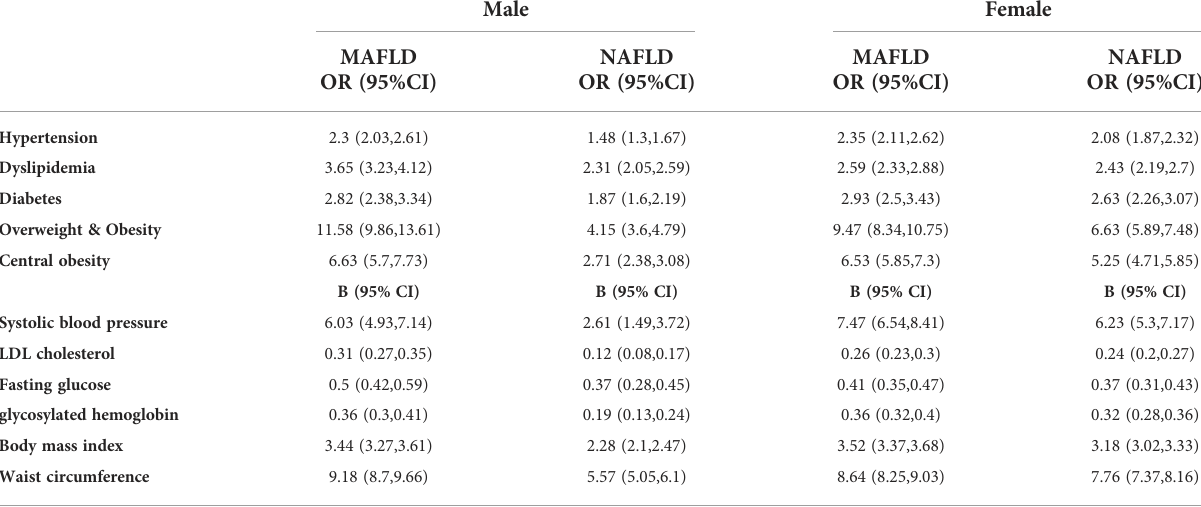
TABLE 3 Risk of hypertension, dyslipidemia, diabetes, central obesity, overweight and obesity in MAFLD and NAFLD